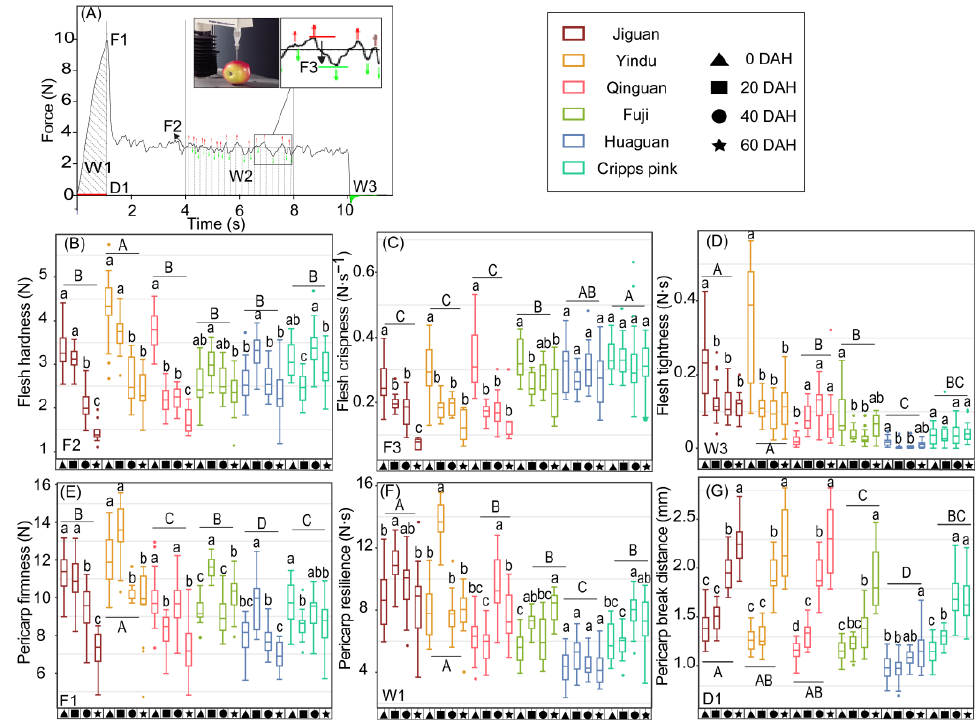
Figure 1. Textural properties of ‘Jiguan’, ‘Yindu’, ‘Qinguan’, ‘Fuji’, ‘Huaguan’, and ‘Cripps pink’ apple fruit stored at 25 ± 1 °C for 0, 20, 40, and 60 d. ( A ) Apple pulp puncture force-displacement curve; ( B ) flesh hardness measured by F2: mean force between 4 and 8 s; ( C ) flesh crispness measured by F3: average drop-off of force between 4 and 8 s; ( D ) flesh tightness measured by W3: area after 10 s; ( E ) pericarp firmness measured by F1: the max force; ( F ) pericarp resilience measured by W1: area from 0 to max force; ( G ) pericarp break distance D1: the distance from 0 to max force. DHA means days after harvest. Data were presented by a boxplot which consists of the most extreme values in the data set (maximum and minimum values), the lower and upper quartiles, and the median. In each plot, the capital letters above the symbols indicate significant differences ( p < 0.05) between six cultivars, and the lowercases indicate significant differences ( p < 0.05) between different storage times.